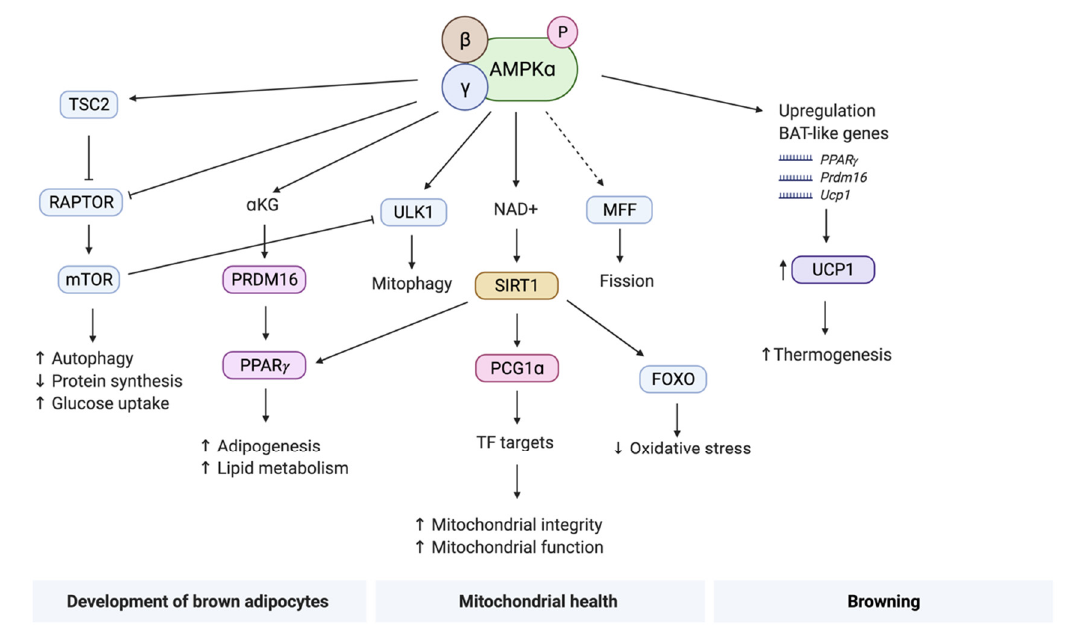
Figure 3. Selection of AMPK-mediated signaling cascades involved BAT activation. The pathways are divided into three processes, namely, the development of brown adipocytes, mitochondrial health, and browning. The signaling cascades depicted here are simplified and are far more complex and interconnected than shown. Firstly, mTOR is a major kinase involved in autophagy and protein syntheses in the developmental stage and glucose uptake in adult brown adipocytes. Secondly, PRDM16 is an essential DNA-binding transcription factor, which can indirectly induce adipogenesis and lipolysis. Thirdly, SIRT1 is an important kinase involved in mitochondrial health and also connects development and mitochondrial homeostasis by influencing the transcription factor PPAR γ . Finally, an abundance of the UCP1 protein is associated with increased thermogenic capacity and is indirectly regulated by AMPK. The role of AMPK in the phosphorylation of MFF has not been proven experimentally; therefore, a dashed line is used in this figure. Abbreviations: AMP-activated protein kinase, AMPK; α -ketoglutaric acid, α KG; forkhead box protein O, FOXO; mitochondrial fission factor, MFF; nicotinamide-adenine-dinucleotide, NAD; peroxisome proliferator-activated receptor- γ co-activator 1, PGC1 α ; peroxisome proliferator–activator receptor, PPAR γ ; PR domain containing 16 protein, PRDM16; regulatory-associated protein of mTOR, RAPTOR; sirtuin-1, SIRT1; transcription factor, TF; tuberous sclerosis complex 2, TSC2; uncoupling protein 1, UCP1; Unc-51 like autophagy activating kinase,